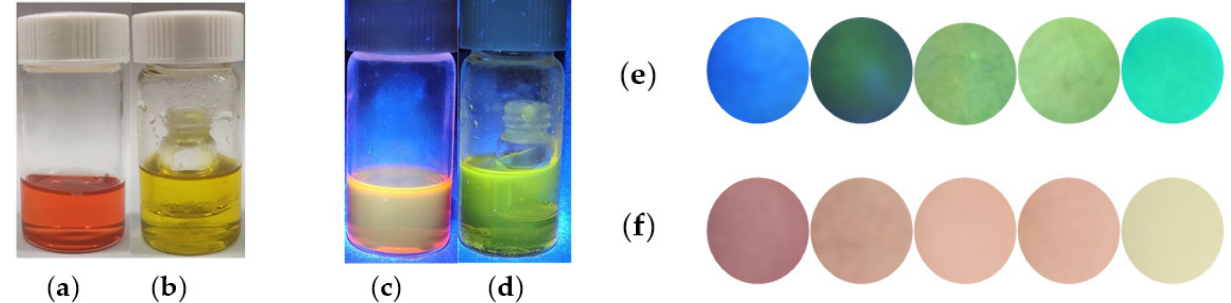
Figure 5. The color changes of ( a , c ) SWJT-4 (10.0 M) (DMSO–HEPES, 1/1, v/v , pH 7.4) solution and ( b,d ) exposure to DCP vapors under visible light or ultraviolet light. Paper sensors that visually detect different concentrations of DCP under ultraviolet light ( e ) and visible light ( f ). From left to right: [DCP] = 0 mM, 1.0 × 10 − 3 mM, 1.0 × 10 − 2 mM, 1.0 × 10 − 1 mM, 1.0 mM.